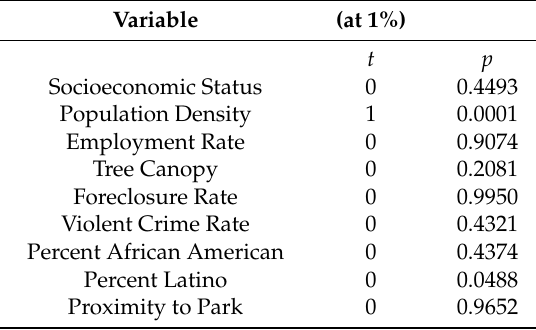
Table 2. Results from the Kolmogorov-Smirnov test comparing the distribution of the nine variables with exhaustive and optimized sample, respectively. The p -value indicates the significance